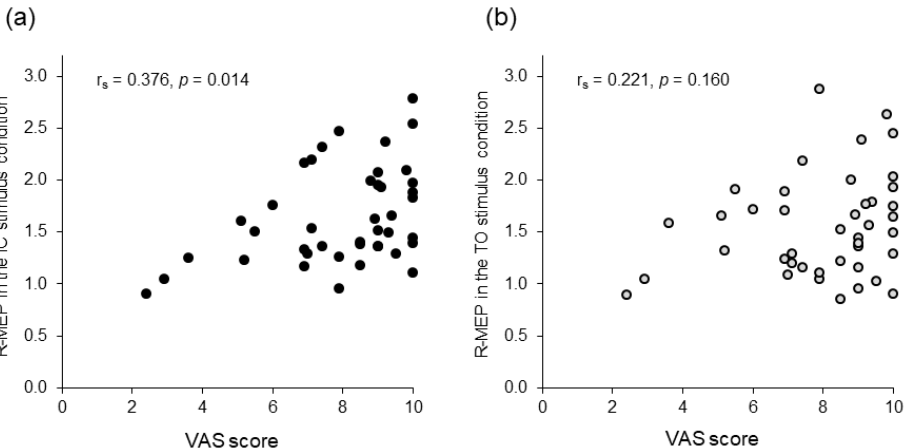
Figure 5. Scattergram representing the relationship between the visual analog scale (VAS) scores and relative motor evoked potentials (R-MEPs). ( a ) Initial contact (IC) stimulus condition. ( b ) Toe-off (TO) stimulus condition. The x -axis denotes the degree of attention evaluated using the VAS score. The y -axis denotes the R-MEPs as surrogates of changes in corticospinal excitability compared to the baseline condition.